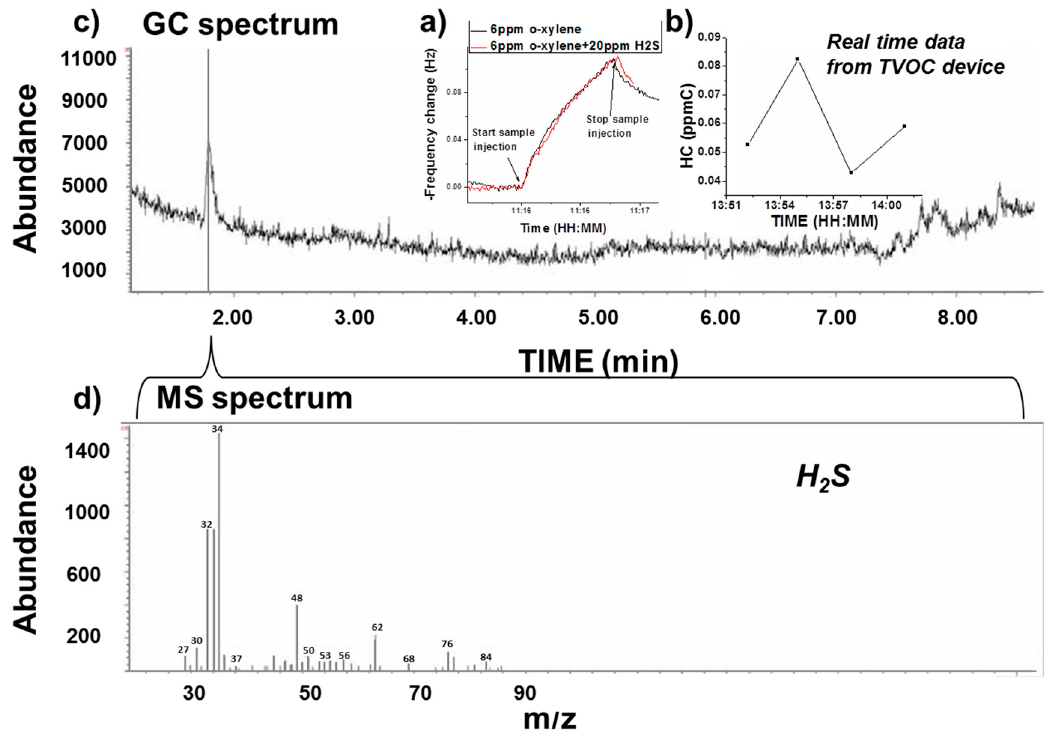
Figure 5. Selectivity validation test to H 2 S with artificial gas sample ( a ) and gas sample from Mammoth Spring, Yellowstone National Park. Real-time test was done on the new VOC device ( b ) and gas sample was collected for GC-MS analysis in the lab ( c , d ). The single peak in the chromatogram confirmed non-significant concentrations of other VOCs, and a presence of H 2 S.